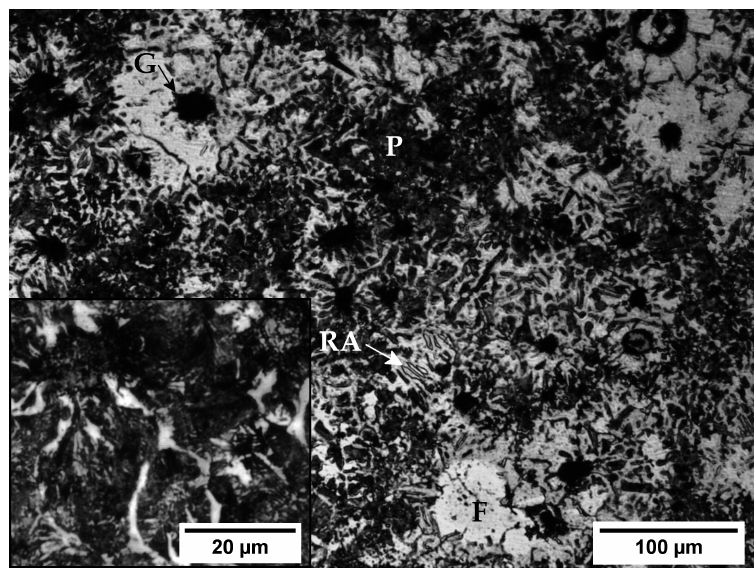
Figure 3. Microstructure of the samples cooled under forced air flow after 15 min of annealing at 880 ◦ C. G: Graphite; F: Ferrite; P: Pearlite; RA: Retained austenite.